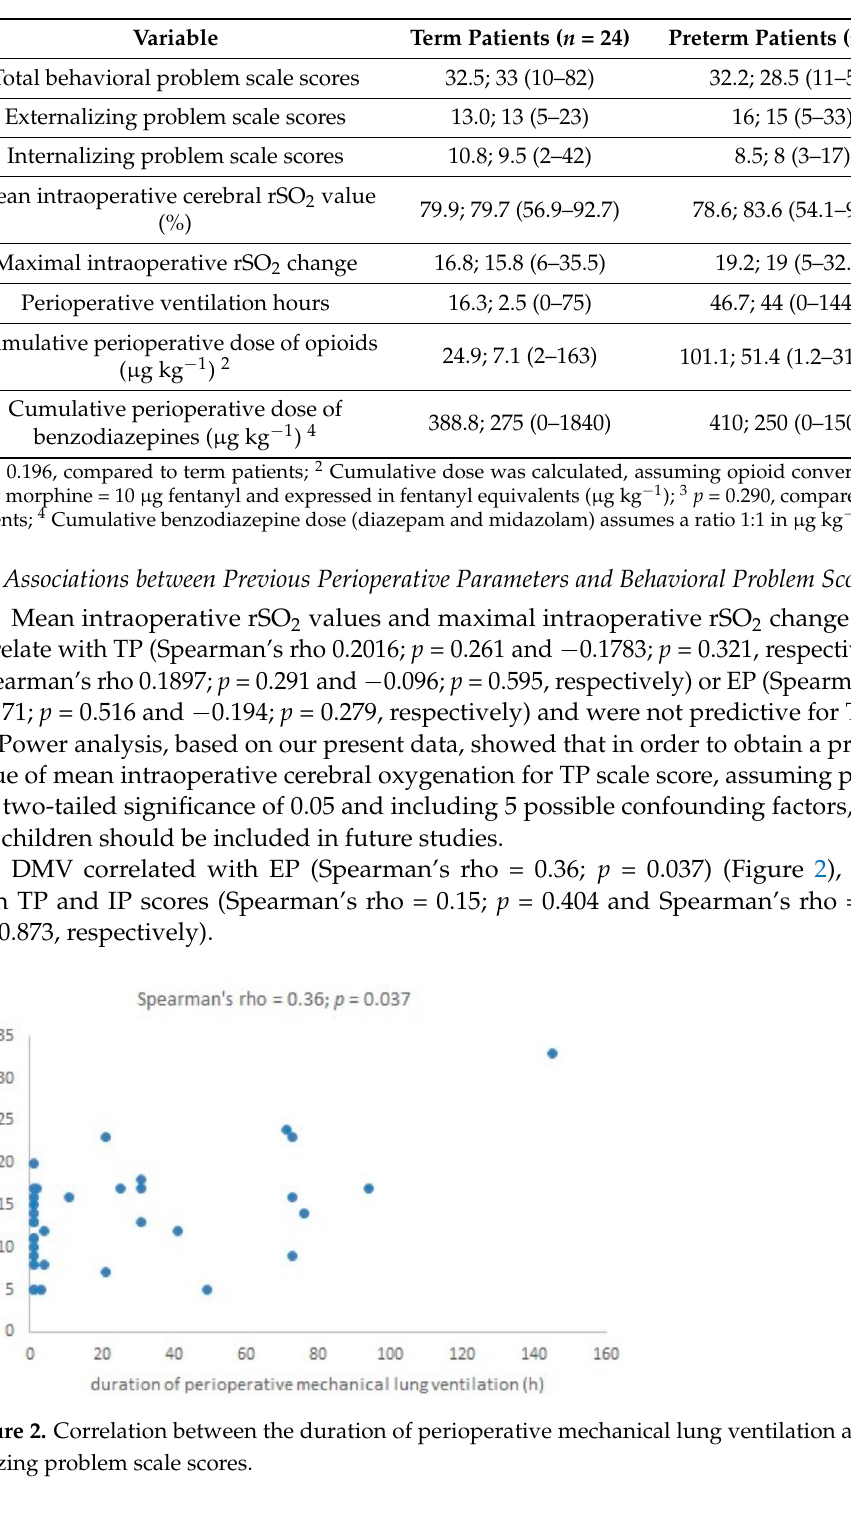
Table 2. Comparison of primary and secondary outcome variables between term and preterm patients. Values are mean; median (range).